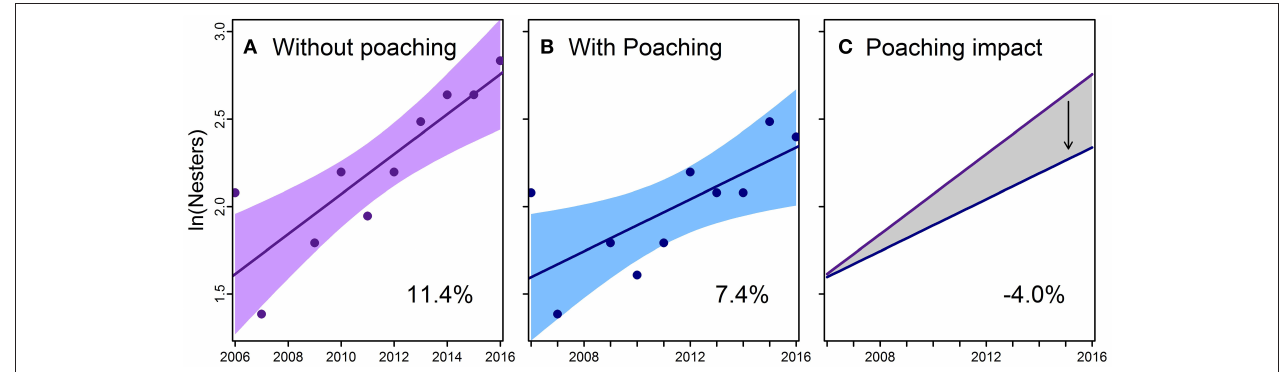
FIGURE 2 | Trends in abundance for green turtles ( Chelonia mydas ) nesting on Saipan, 2006–2016. (A) “Without Poaching” model scenario—theoretical nester abundance with poached nesters added back to observed annual counts using the estimated mean remigration interval of 4.6 years. Linear regression (solid line with shaded 95% confidence interval) through estimated annual nester abundance (points) suggests the population growth rate would be 11.4% without poaching ( p = 0.001; R 2 = 0.74). (B) “With Poaching” model scenario—nester abundance (points) reflects actual levels of poaching, with a linear regression (line and 95% confidence interval shading) suggesting a 7.4% population growth rate ( p = 0.019; R 2 = 0.52). (C) Difference between the two scenarios in (A,B) suggests poaching of nesters decreased the population growth rate by 4.0%, thereby slowing the recovery